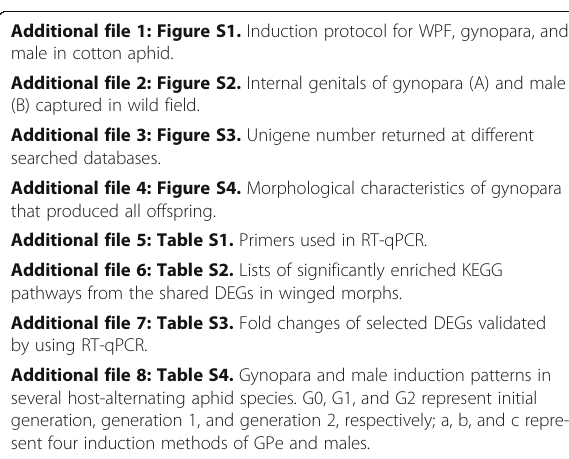
Additional file 1: Figure S1. Induction protocol for WPF, gynopara, and male in cotton aphid. Additional file 2: Figure S2. Internal genitals of gynopara (A) and male (B) captured in wild field. Additional file 3: Figure S3. Unigene number returned at different searched databases. Additional file 4: Figure S4. Morphological characteristics of gynopara that produced all offspring. Additional file 5: Table S1. Primers used in